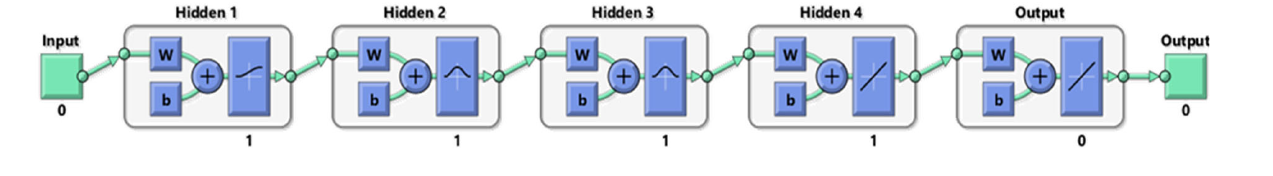
Figure 11. Graphical representation of ANN.